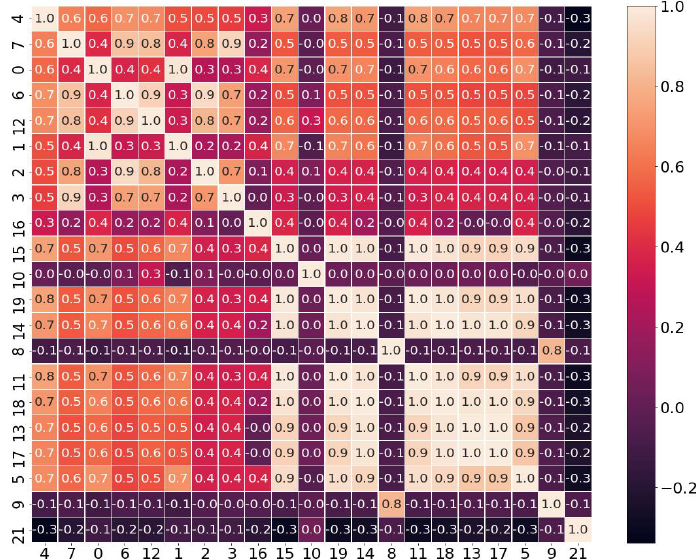
Figure 10. Heat map of coefficient correlation before feature selection.